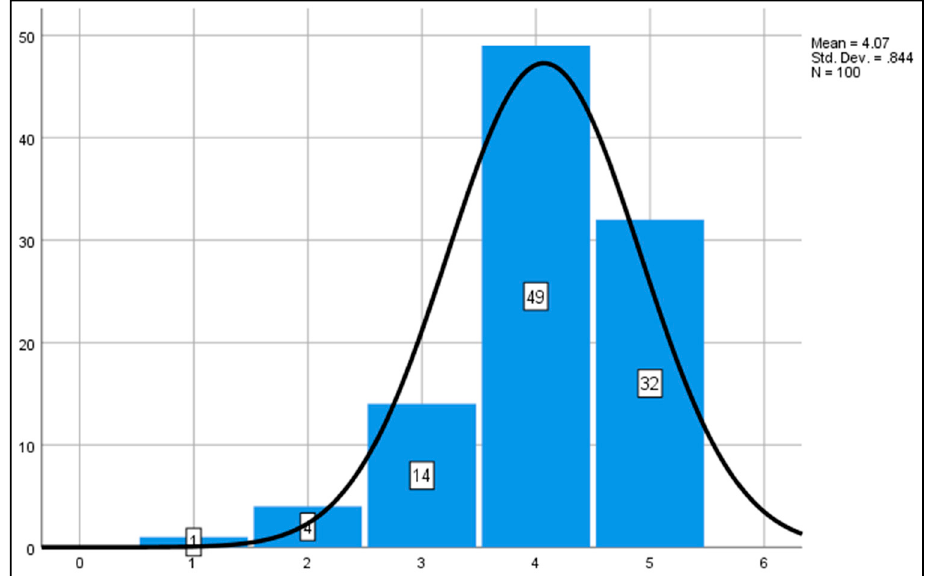
Figure 13 . Freedom and Industry 4.0